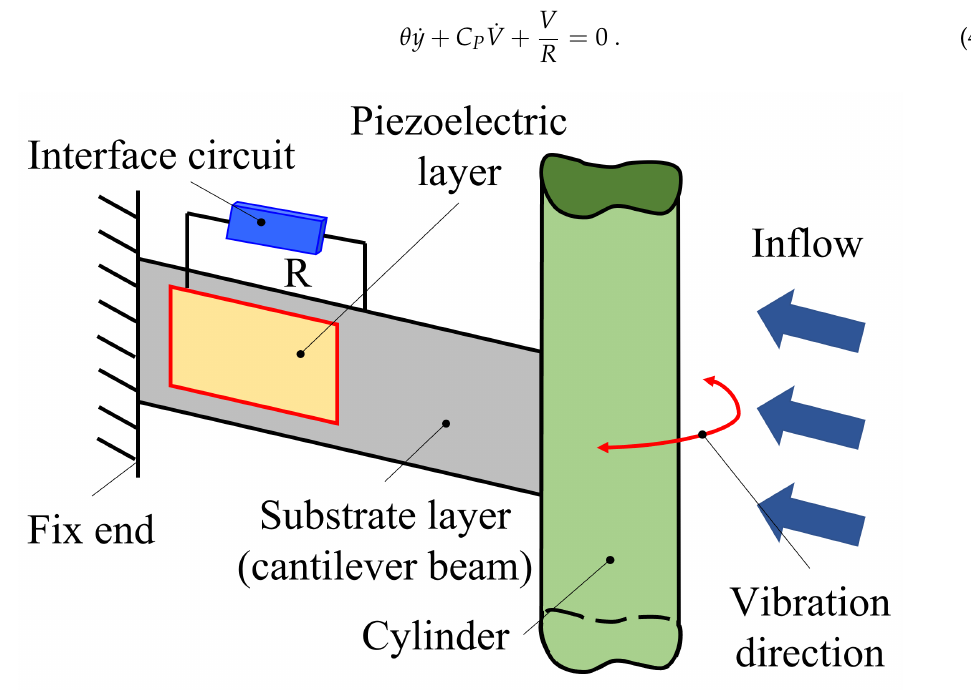
Figure 12. Sketch of a simple piezoelectric energy harvester based on flow-induced